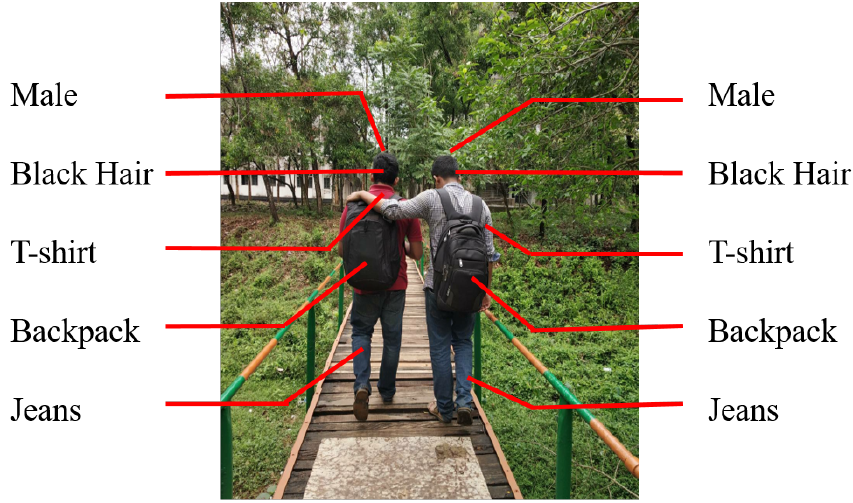
Figure 1. Example of the pedestrian attributes from a multiple pedestrian